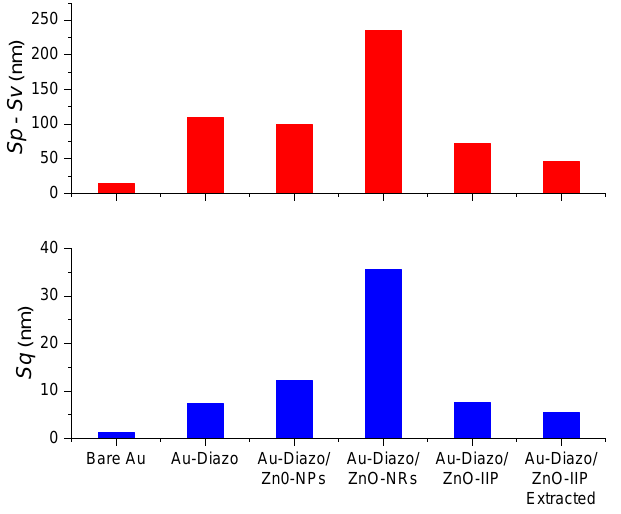
Figure 7. Root-mean-square height ( Sq ) and peak-valley height ( Sp-Sv ) values after the different functionalization steps, from bare gold substrate to electrosynthesis of IIP and the further extraction of the imprinted Hg 2+ template